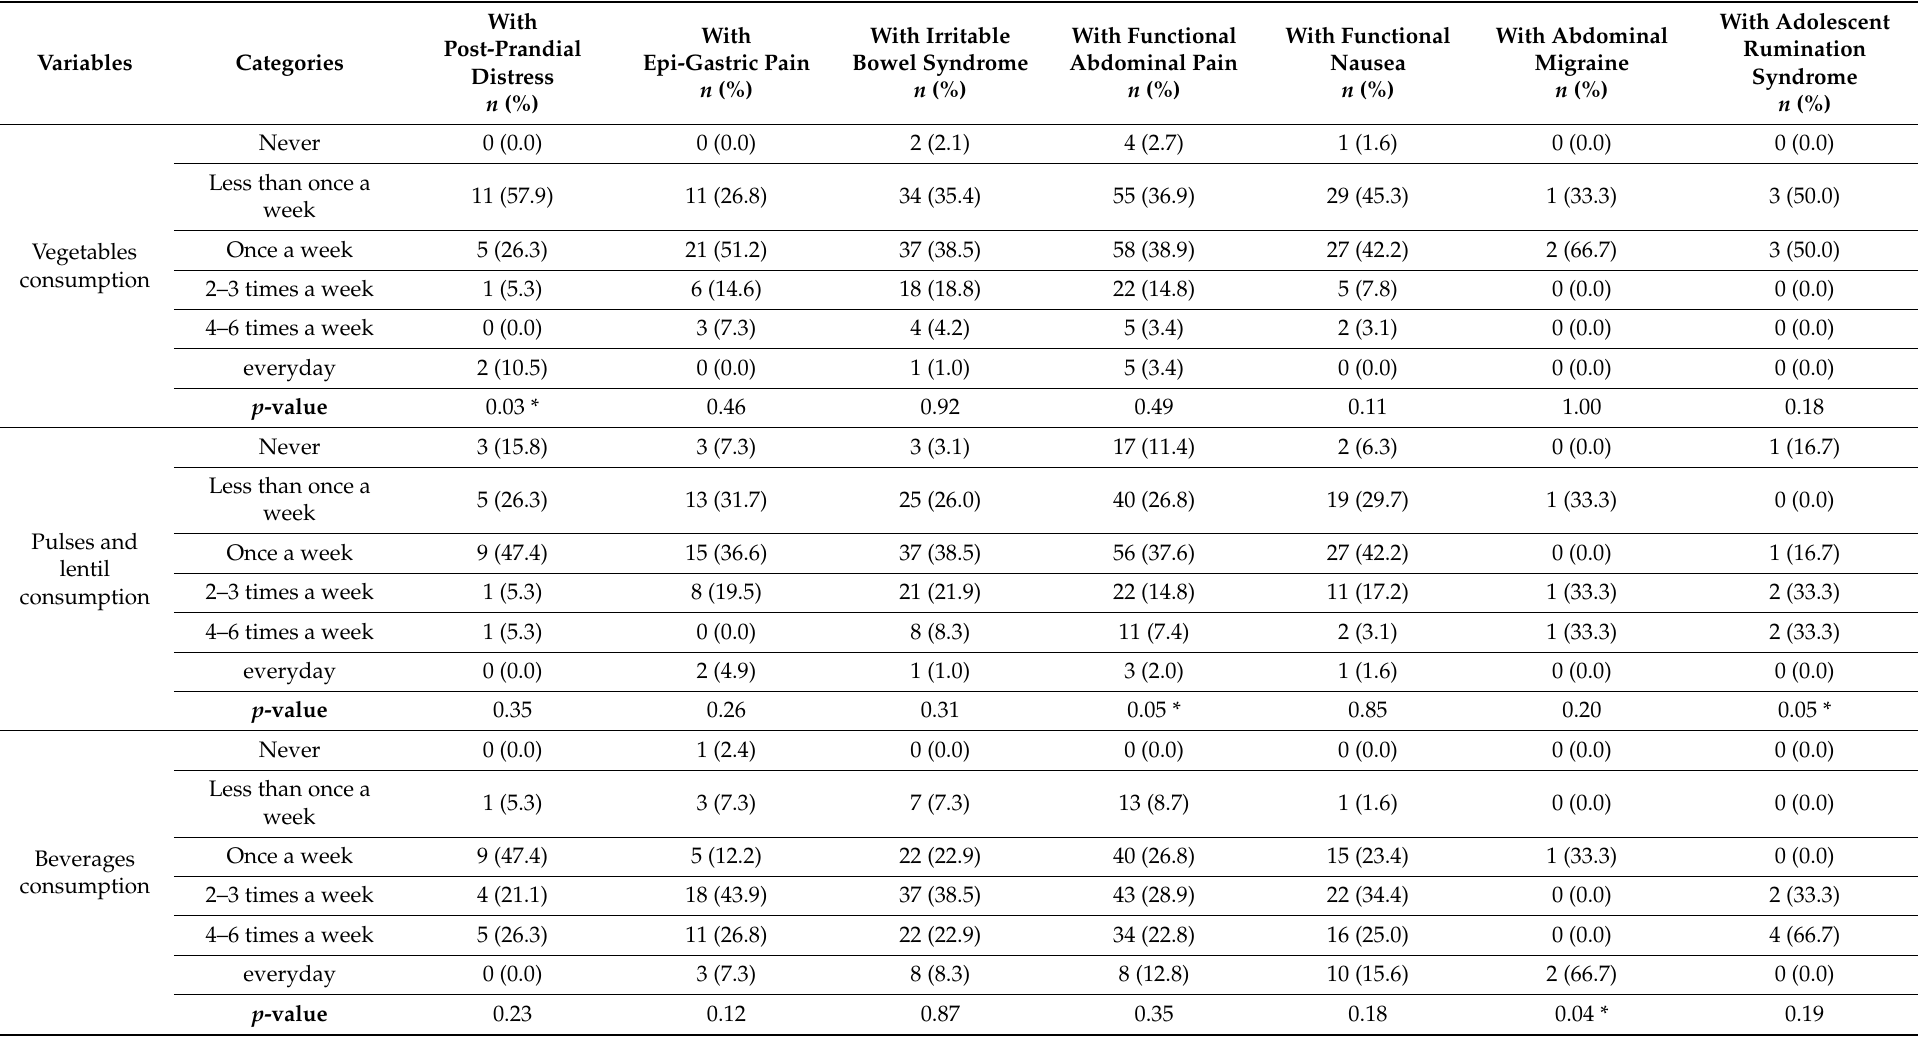
All values marked with an asterisk (*) indicate statistically significant associations between the